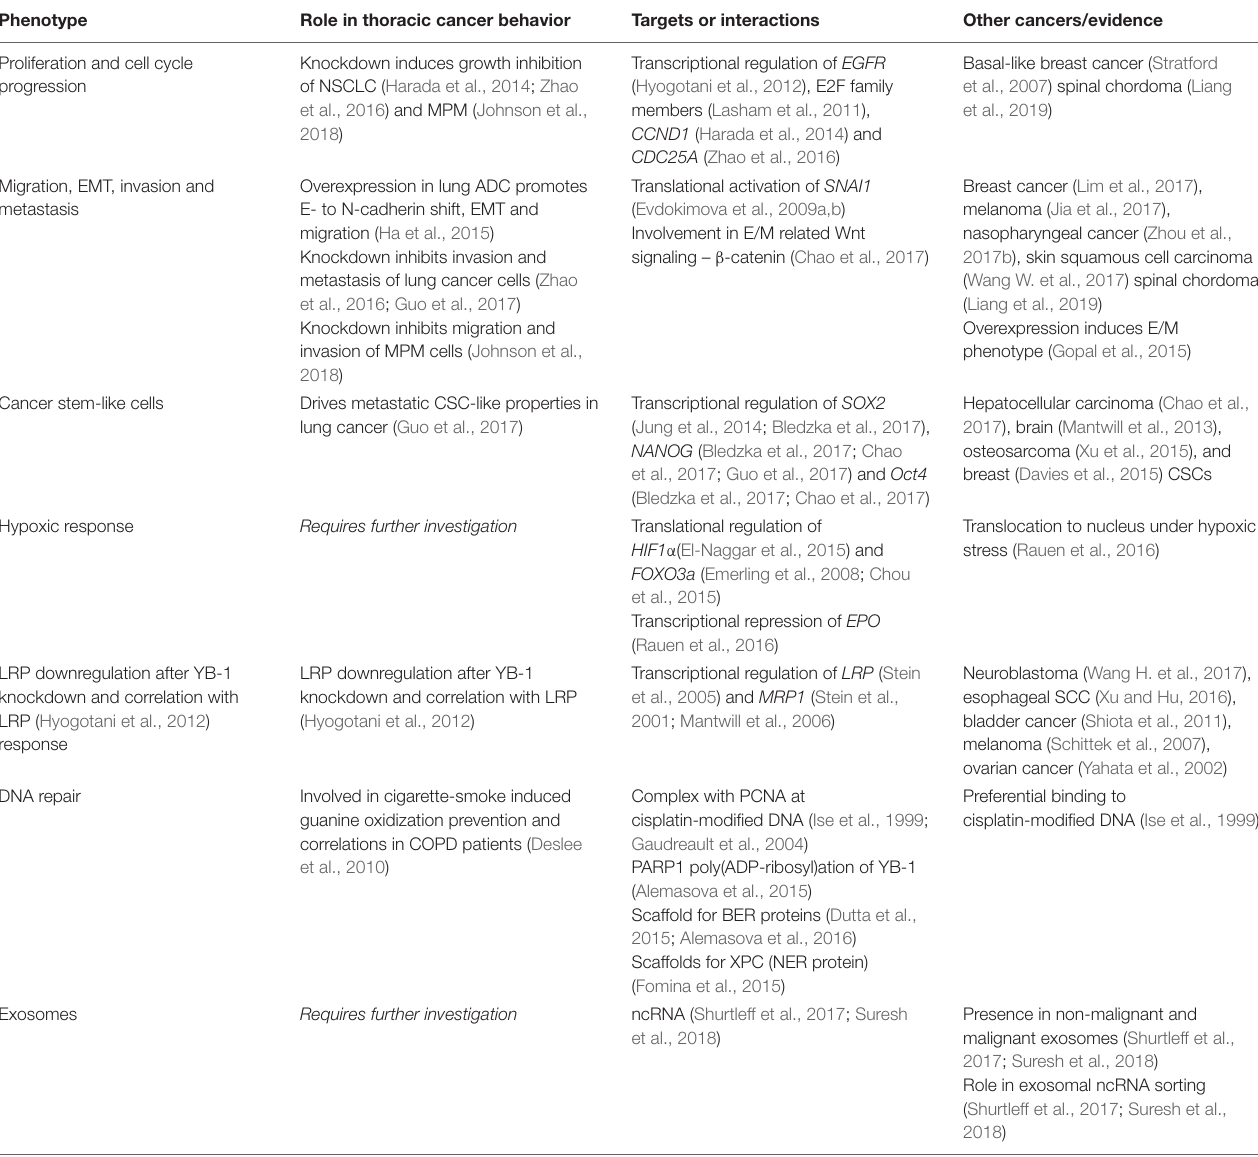
TABLE 1 | Roles and interaction partners of YB-1 related to thoracic cancer